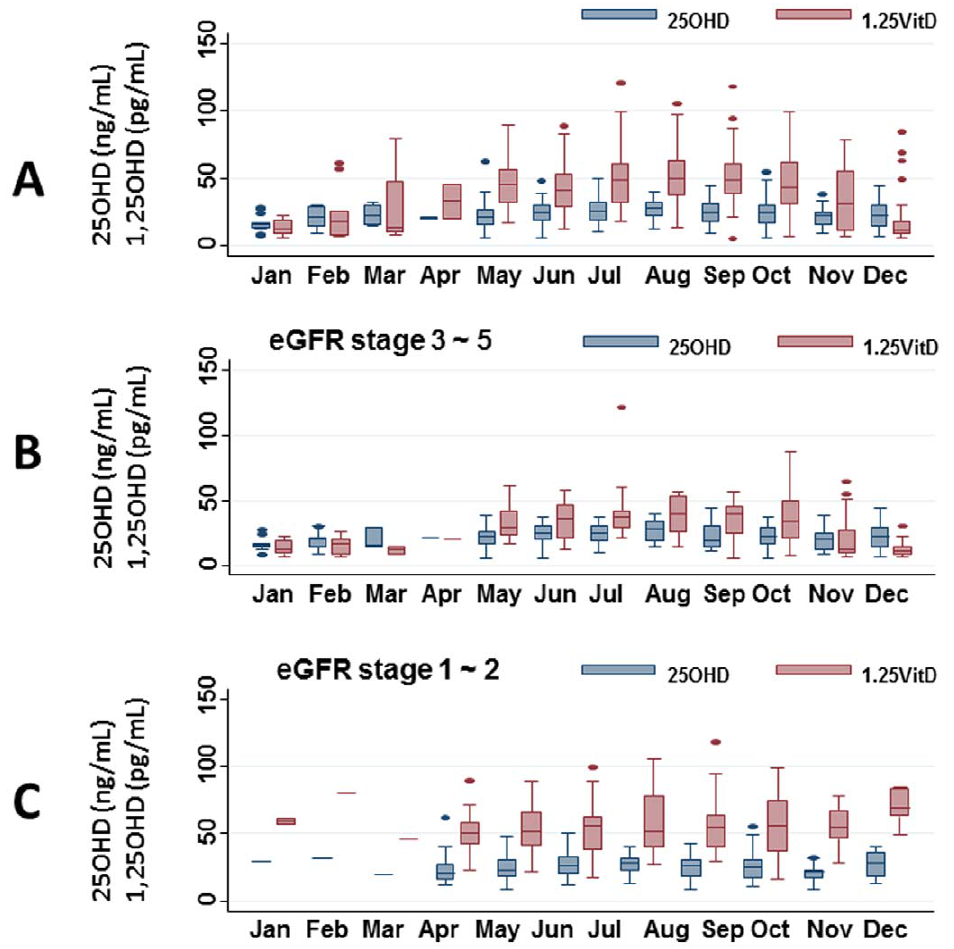
Figure 2. Serum 25OHD and 1,25OHD levels from January to December in patients with type 2 diabetes and with CKD stage 1 , 5. Associations are shown using the total study population (A), a subpopulation with CKD stages 3 , 5 (B), and a subpopulation with CKD stages 1 , 2 (C). The central box extends from the 25 th to the 75 th percentile. All dots outside this range are outliers, which are not typical of the rest of the data.